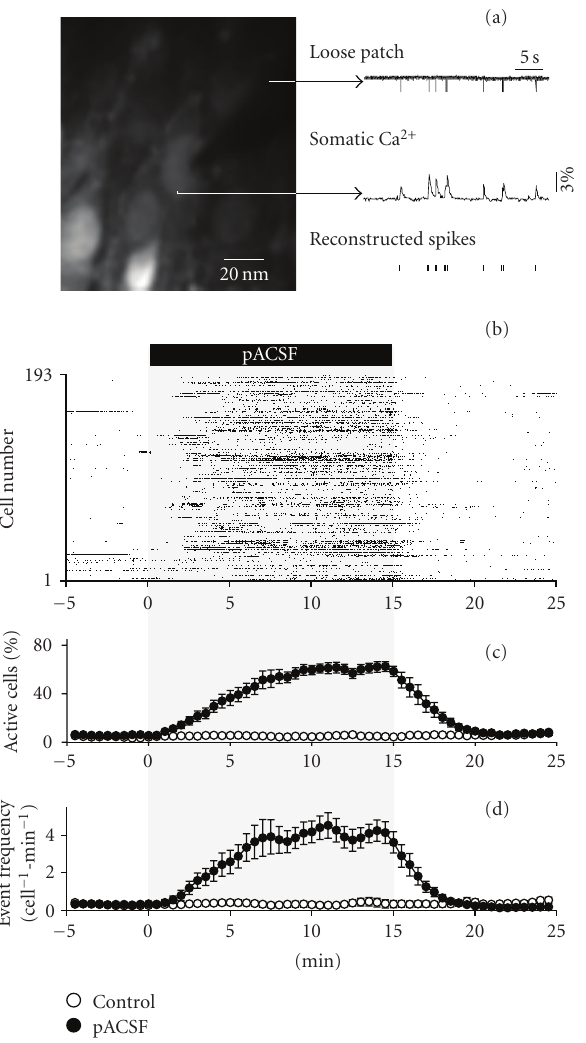
Figure 1: Physiologically relevant ionic conditions induce a reversible increase in spontaneous activity of hippocampal CA3 neurons in organotypic cultures . (a) Simultaneous loose patch-clamp recording and time-lapse imaging of somatic calcium signal from a hip- pocampal CA3 neuron loaded with Oregon green 488 BAPTA-1AM. The timings of action potentials can be reconstructed from the onset timings of individual calcium rise events. (b) Representative example of a change in CA3 network activity following 15-min replacement of normal extracellular solution with pACSF. Each dot represents a single-calcium transient. (c) pACSF-induced change in the percentage of active cells to the total number of cells monitored. (d) pACSF-induced change in the mean event frequency per cell. Open and closed circles indicate group without ( N = 5 slices, Control) and with pACSF replacement ( N = 8 slices, pACSF), respectively. Data are means ±